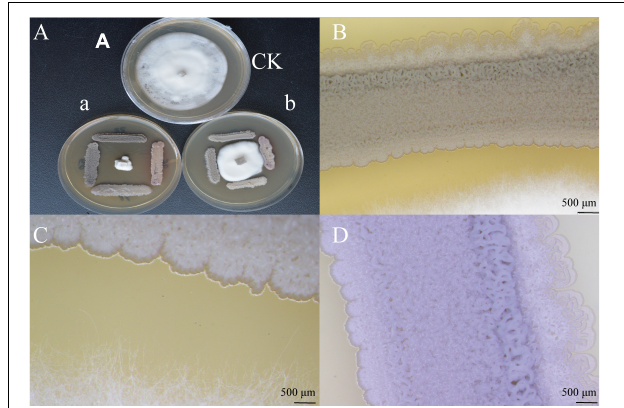
FIGURE 5 | Intelligent live digital imaging of the response of endophytic strain XEGI50 to V. dahliae under a laser microscope. (A) In vitro evaluation of antagonistic activity of strain XEGI50; (a) V. dahliae could not grow after seven days of incubation with antagonistic strains, (b) V. dahliae grows after three days then we inoculate the antagonistic stains at four sides of the agar plate. (B) Response of strain XEGI50 to V. dahliae at 1.25 × magnification; (C) Response of strain XEGI50 to V. dahliae at 4 × magnification showed white powder appeared only on one the side which is facing the pathogenic fungi; (D) Different changes of the behavior of strain XEGI50 on the both sides due to the stress at 2.5 ×